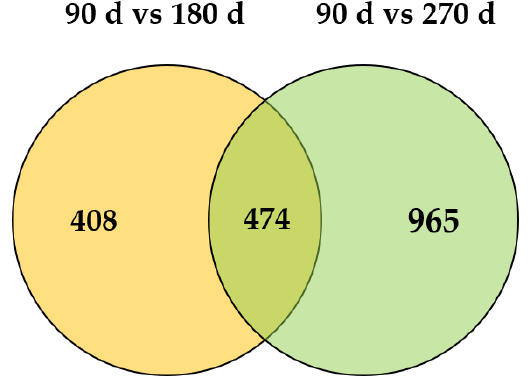
Figure 3. Venn diagram depicting the overlap between the two sets of differentially expressed genes.